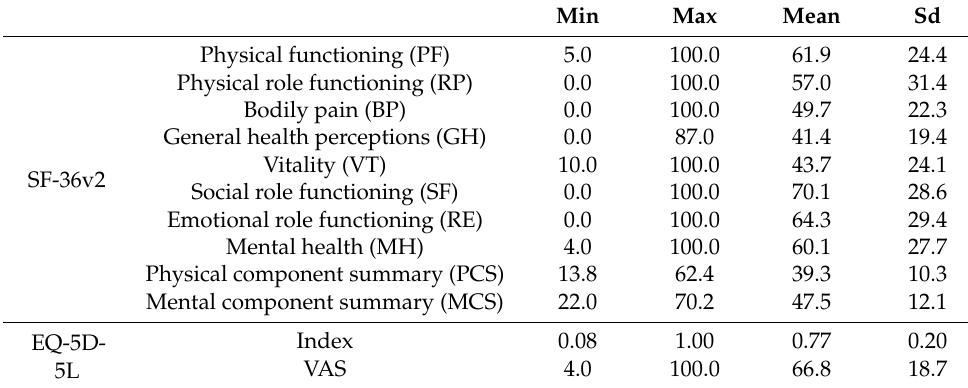
Table 3. Health status and quality of life variables.